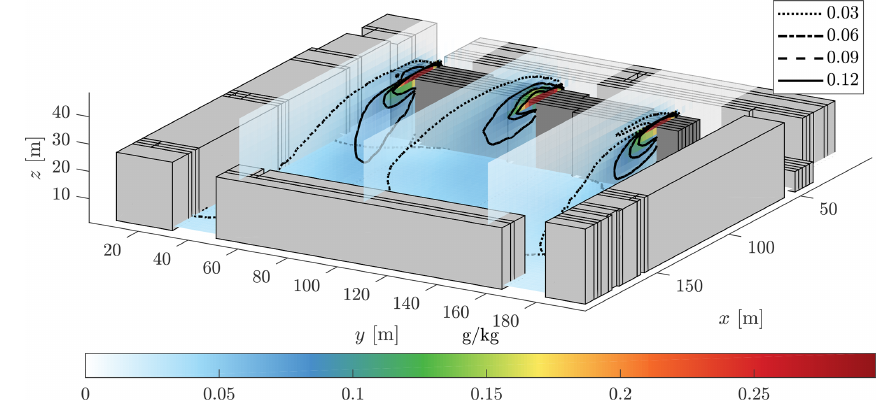
Figure 13. Three vertical slices and one horizontal slice through the difference between final 1h means of simulations with and without a green roof. The Eastside building is coloured in darker grey.